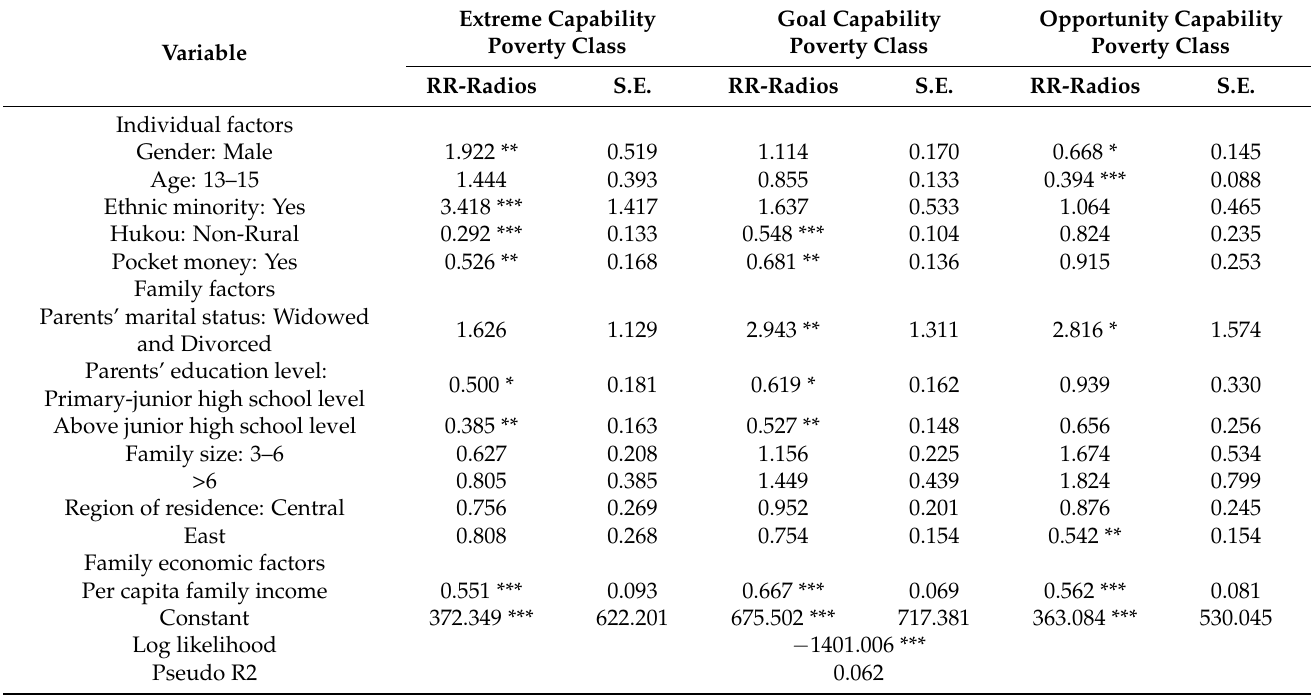
Table 5. Multinomial logistic model